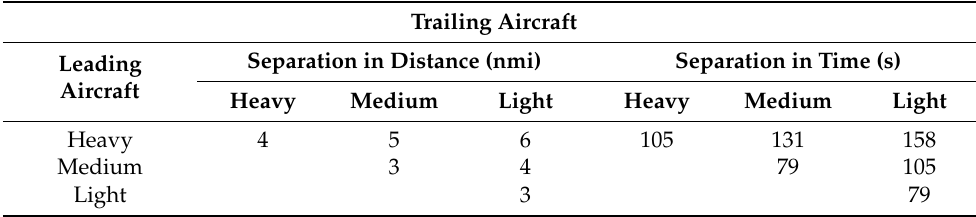
Table 2. ICAO Minimum Wake Turbulence Separation